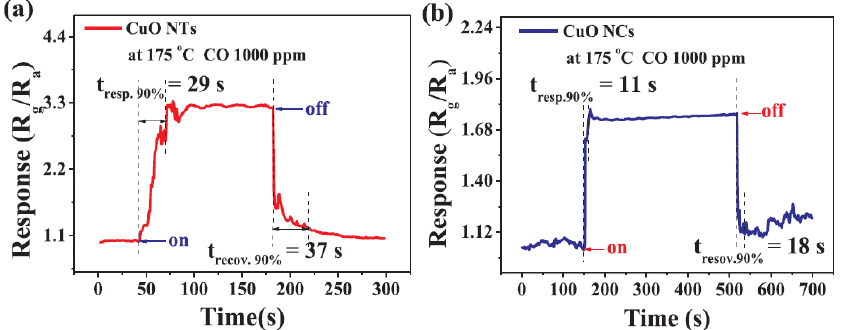
Figure 5. The response and recovery times of the ( a ) CuO NTs and ( b ) CuO NCs exposed to 1000 ppm Reprinted with permission from [54]. Copyright 2018 Elsevier.